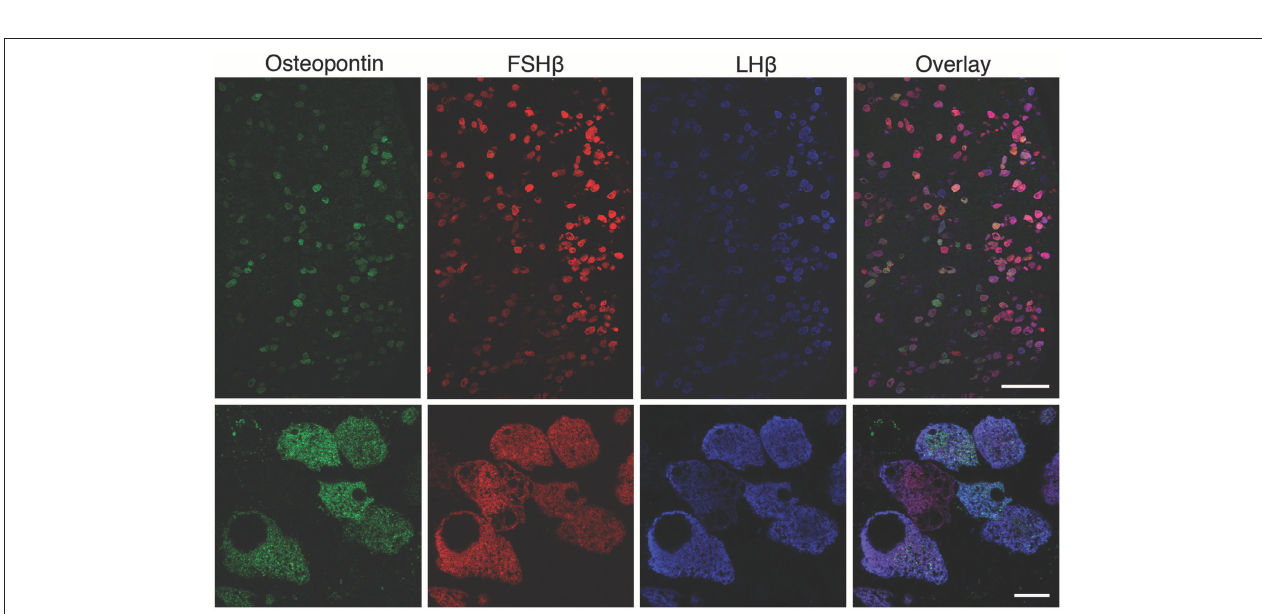
FIGURE 4 | OPN expression in the adult pituitary tissue is sex-specific and restricted to gonadotrophs. Immunofluorescence staining for OPN and LH β in the anterior pituitary tissue from adult female (top) and male (bottom) rats. Scale bar of 20 µ m applies to all images.